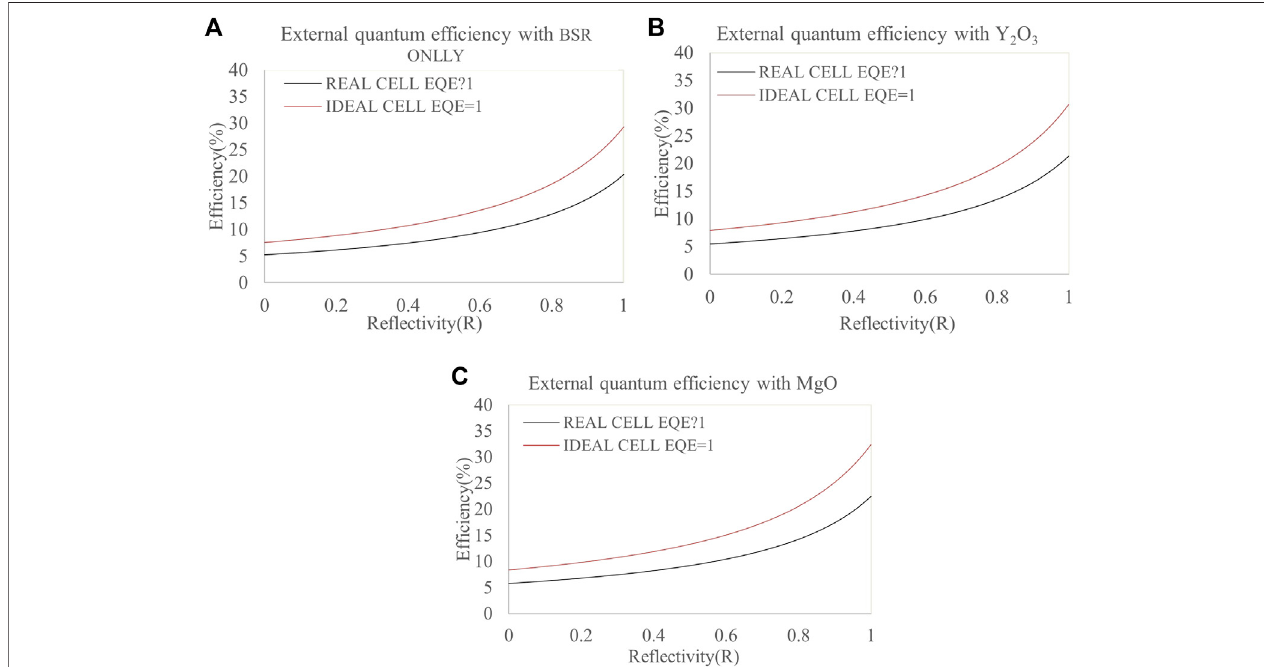
FIGURE12| Effectofincreasingemittertemperatureontheef fi ciency( η ) of a real 0.25 cm 2 InGaAs TPV cell (avg EQE = 0.7097) with respect to the re fl ectivity R of the BSR. The ef fi ciency of the cell increases with the increasing T.